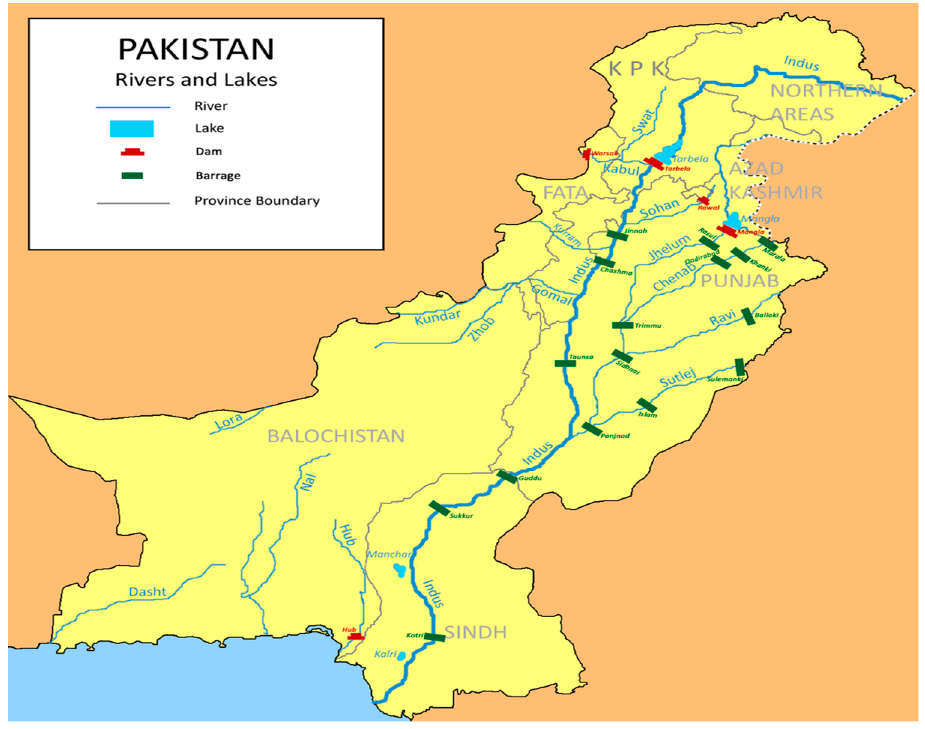
Figure 11. Rivers in Pakistan.